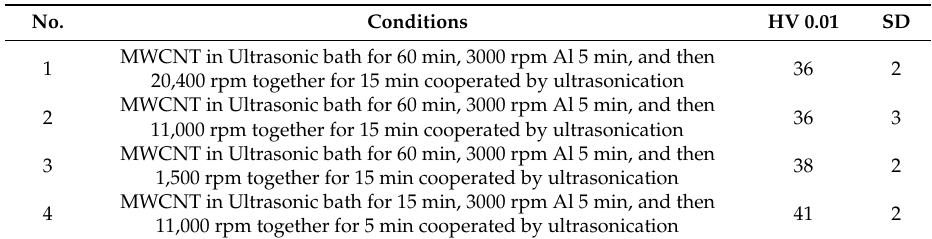
Figure 3. SEM/SE images from ~1.7 g/mL MWCNT in isopropanol solution treated in an ultrasonication bath (35 kHz) after ( a ) and ( b ) 15 min, and ( c ) and ( d ) 60 min; ( e ) TEM image from the nanotubes processed by the assisted sonication method (60 min’ ultrasonication followed by a simultaneous sonication for 15 min at 20,400 rpm). Table 4. Microhardness of Al-0.75 wt. % MWCNT prepared by the assisted sonication method, compacted at ~400 MPa and